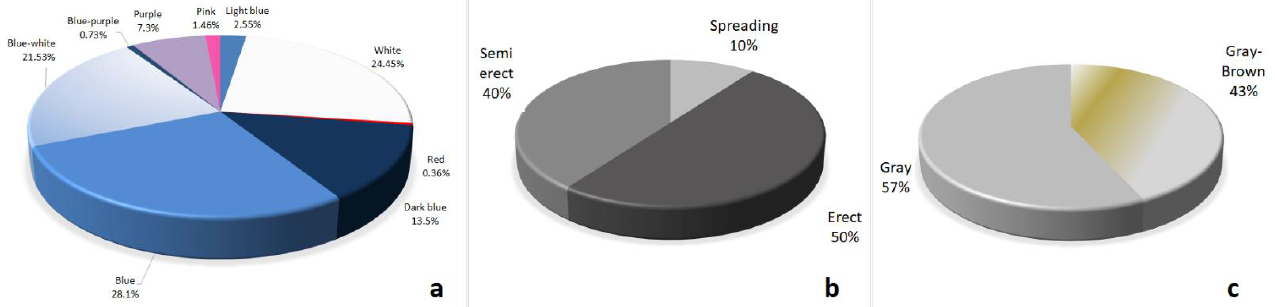
Figure 2. frequency distribution of qualitative traits in the whole collection. a the color of flowers; b Figure 2. Frequency distribution of qualitative traits in the whole collection. ( a ) the color of flowers; growing type; c seed color. ( b ) growing type; ( c ) seed